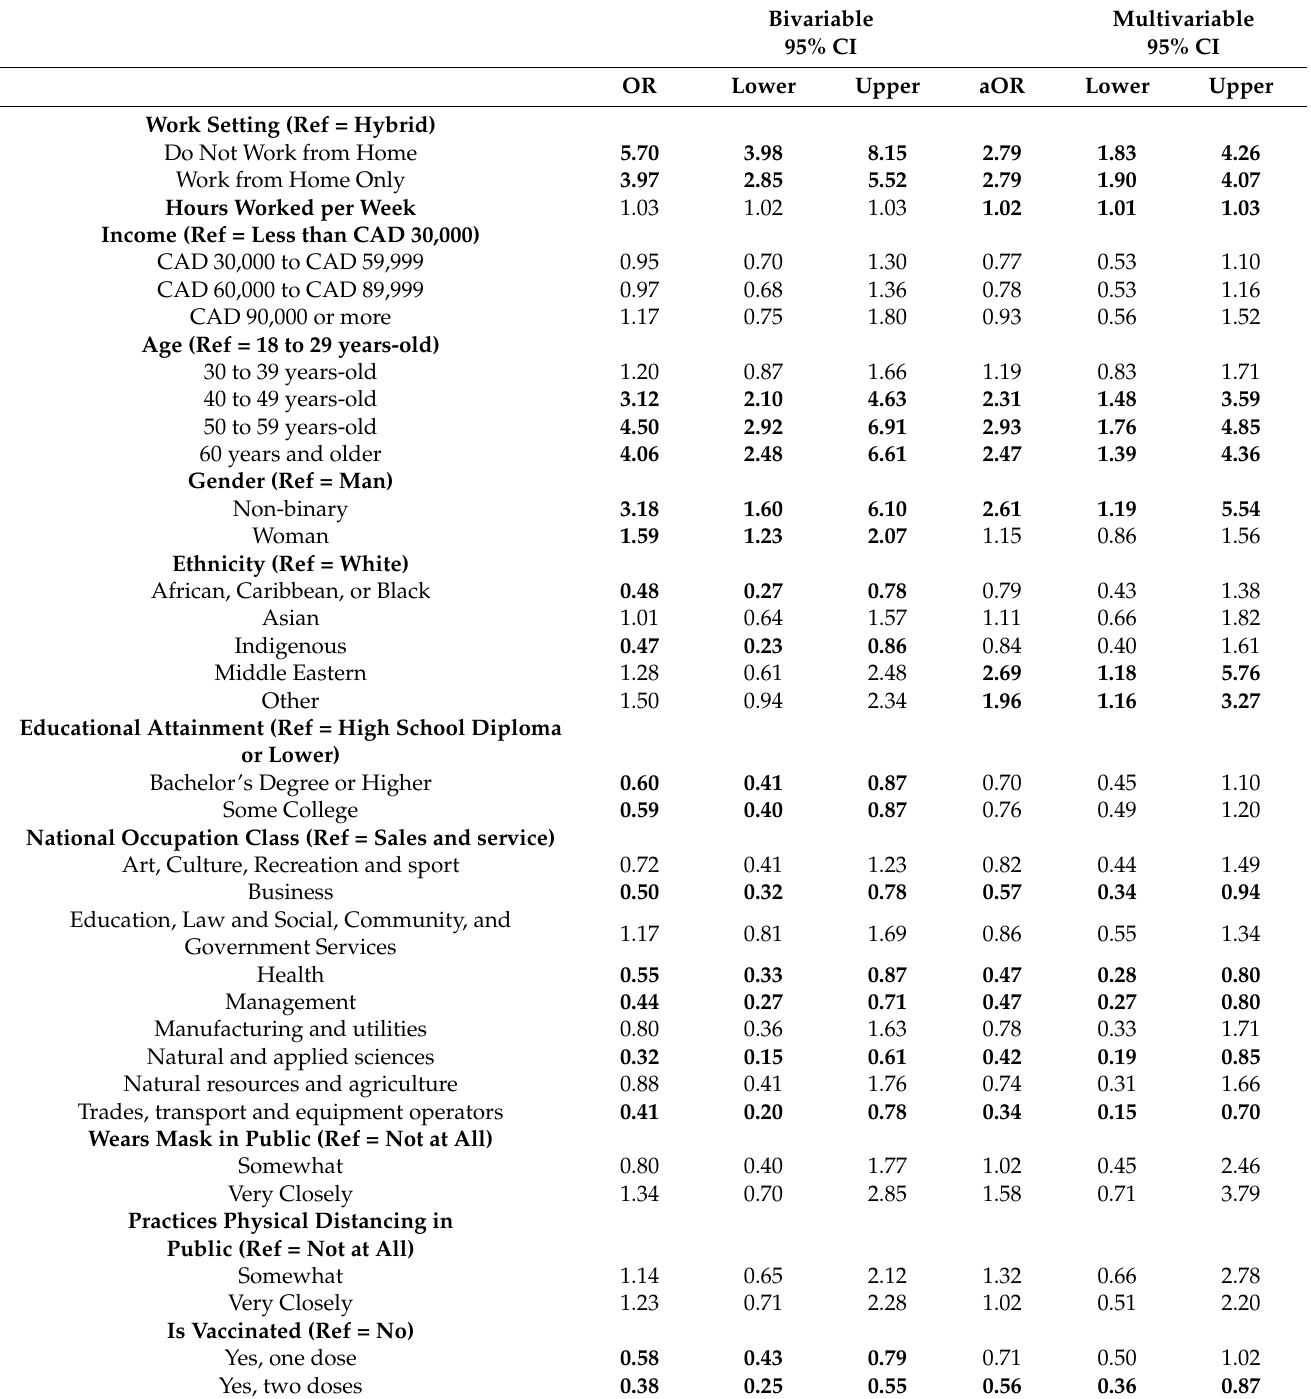
Table 2. Bivariable and Multivariable Logistic Regression Models. Bivariable